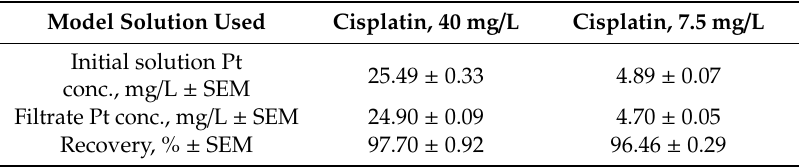
Table 3. Ultrafiltration system recovery ( n =